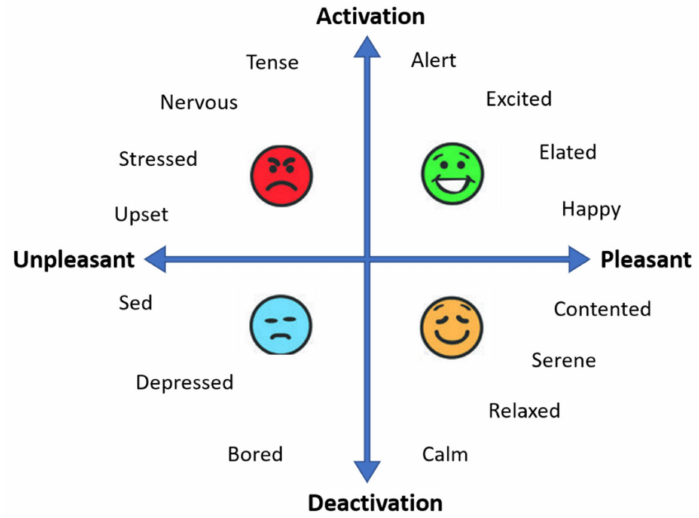
Figure3. Graphicalrepresentationofthecircumplexmodelofa ff ectwiththehorizontalaxisrepresenting the valence dimension and the vertical axis representing the arousal dimension. Adapted from